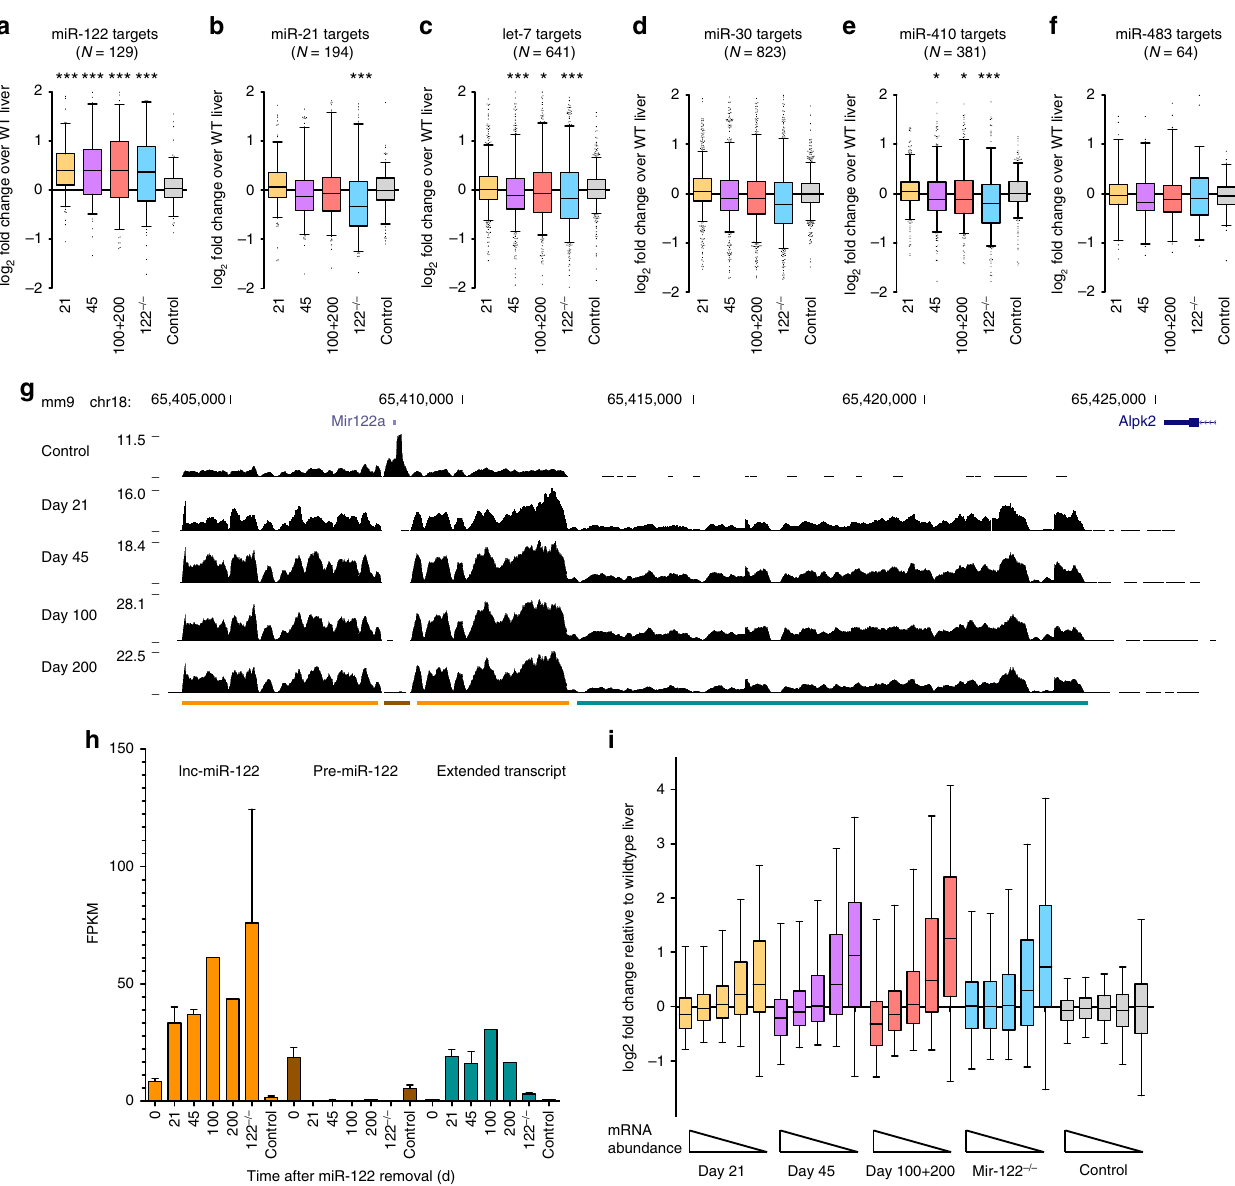
Fig. 4 Mir122 removal increases miR-122 target expression and reduces targets of other microRNAs. a − f Box-plot of log 2 fold change expression of predicted targets of microRNAs (* p < 0.05; *** p < 0.001 by Kruskal − Wallis test followed by Dunn ’ s multiple comparison test, comparing against control). g Normalized RNA-seq mapped reads across the long noncoding miR-122 transcript (lnc122). Below is the location of pre-miR-122 (brown), lnc122 (orange) and an extended transcript after miR-122 removal (teal). h Quanti fi cation of fragments per kilobase of transcript per million mapped reads (FPKM); n = 3 per condition with mean ± s.d. except 100 and 200 where n = 1. i Quintile bins of mRNA expression and deviation from the wild-type liver sample